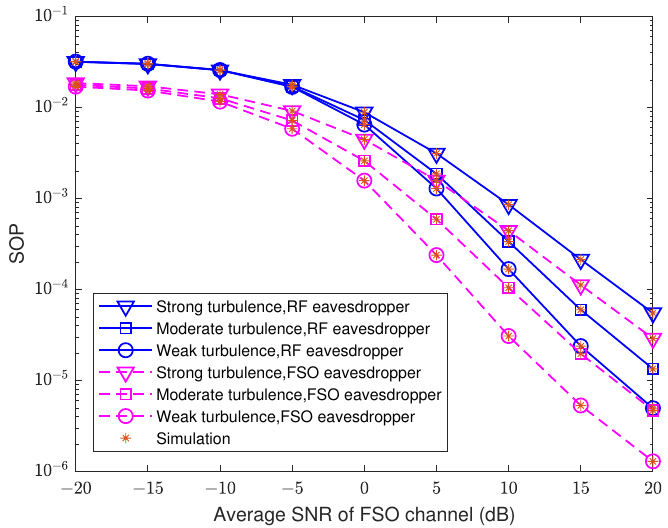
Figure 6. Underdifferent turbulence intensity, the relationship between the SOP of the hybrid system with RF and FSO link eavesdropping and the average SNR of the FSO channel.